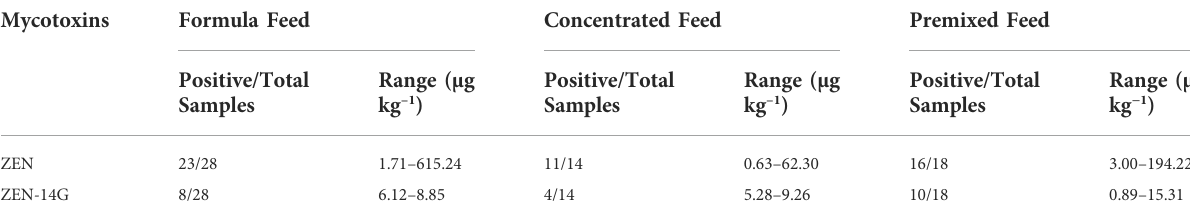
TABLE 4 Occurrence of ZEN and ZEN-14G in formula feed, concentrated feed, and premixed feed samples.